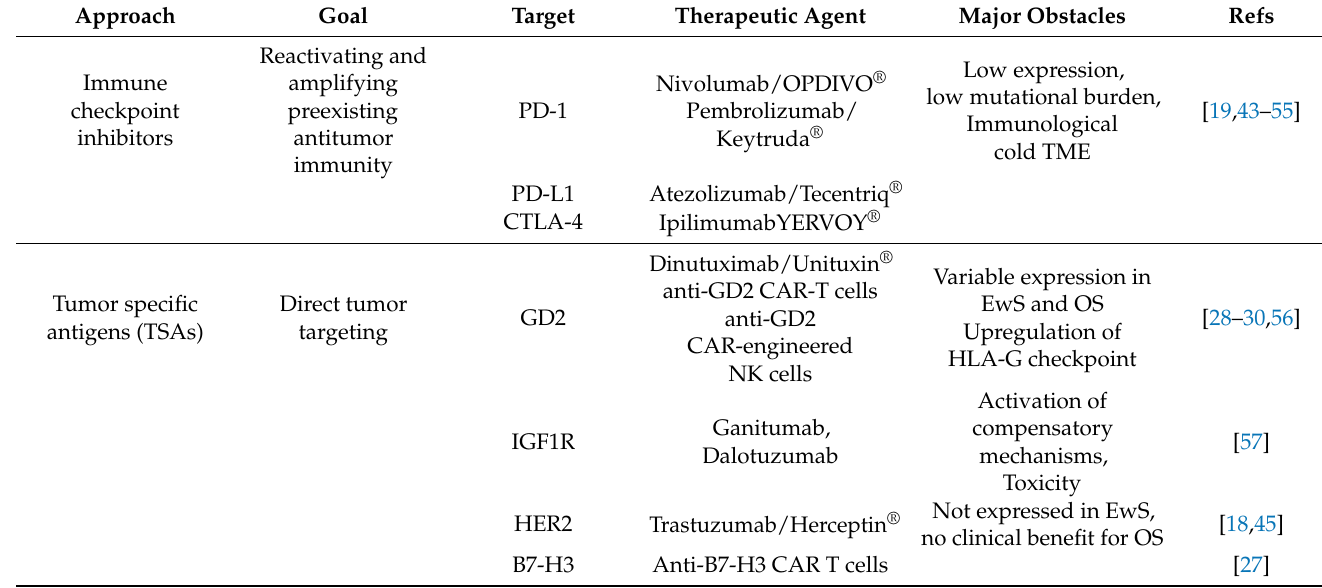
Table 1. Immunotherapy of pediatric bone